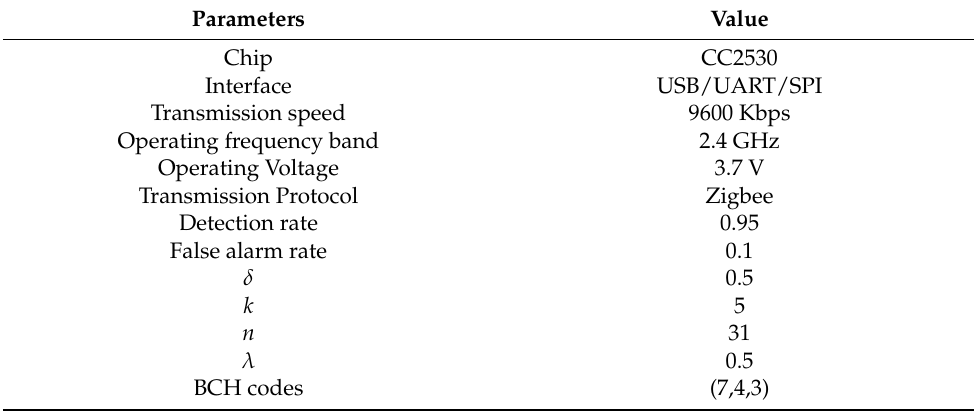
Figure 6. The weighted error probabilities at the AFC and EFC with an increasing number of sensors in time-varying channel conditions. 5.2. Physical Experiment Results. Table 4. The parameters of the sensor